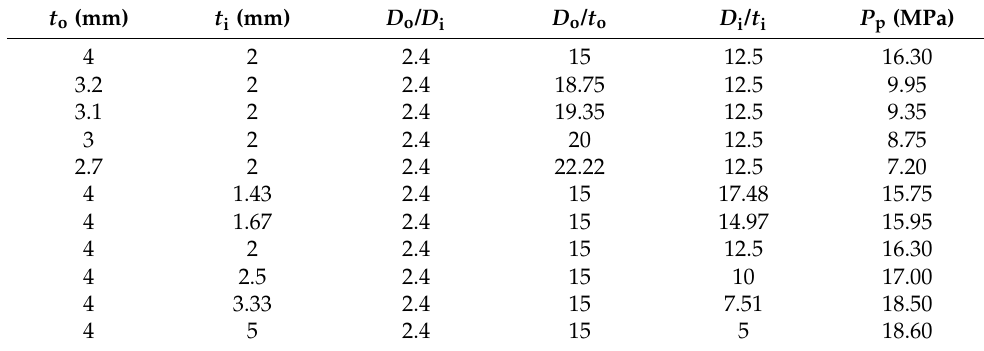
Table 11. Buckle propagation pressure of PIP ( D o = 60 mm, D i = 25 mm).